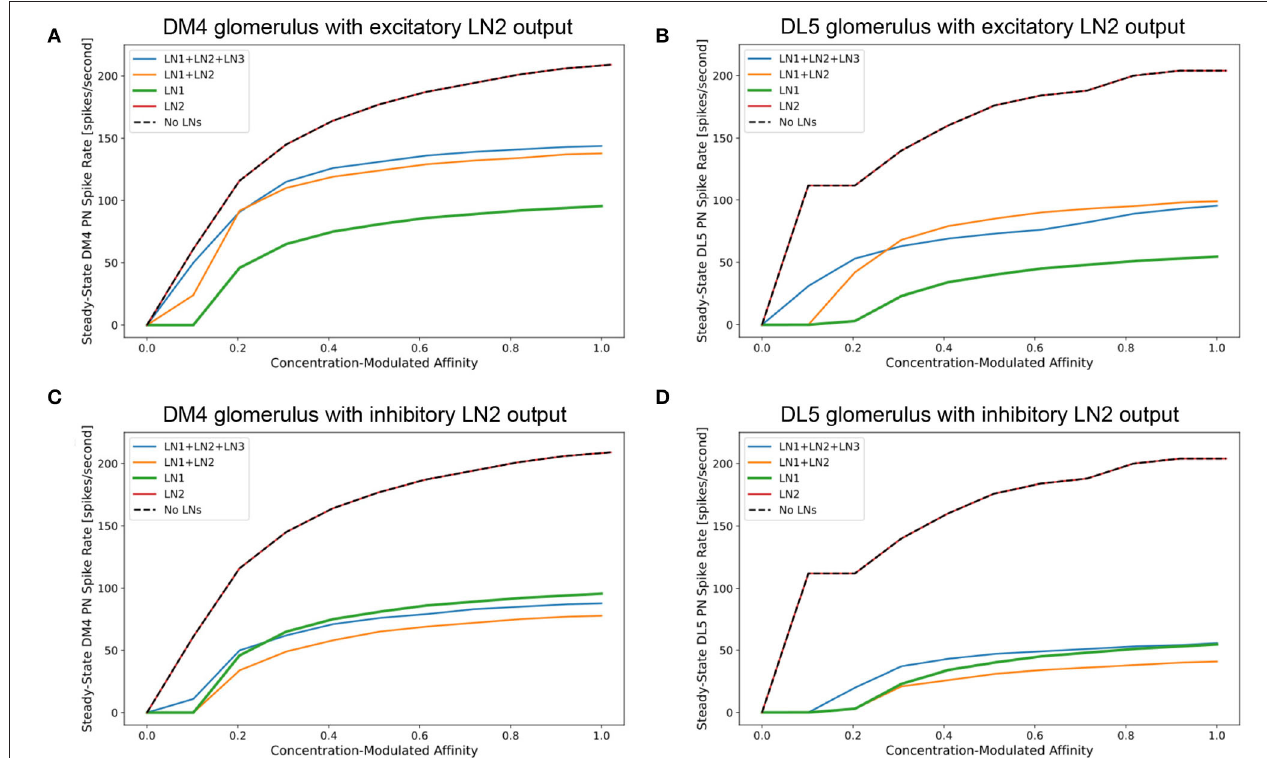
FIGURE 9 | Characterization of PN responses of the single (isolated) DM4 and DL5 glomerular circuits. (A) DM4 PN steady-state firing rate across different constant odorant concentration levels. (dashed black) No LN is present. (green) Only LN1 feedback motif is present. (red) Only LN2 feedback motif is present. (orange) LN1 and LN2 feedback motifs are present. (blue) LN1, LN2 and LN3 feedback motifs are present. (B) DL5 PN steady-state firing rate across different constant odorant concentration levels. LN2 feedback motifs in both (A,B) are assumed to be excitatory. (C) DM4 PN steady-state firing rate when LN2 feedback motifs are assumed to be inhibitory. (D) DL5 PN steady-state firing rate when LN2 feedback motifs are assumed to be